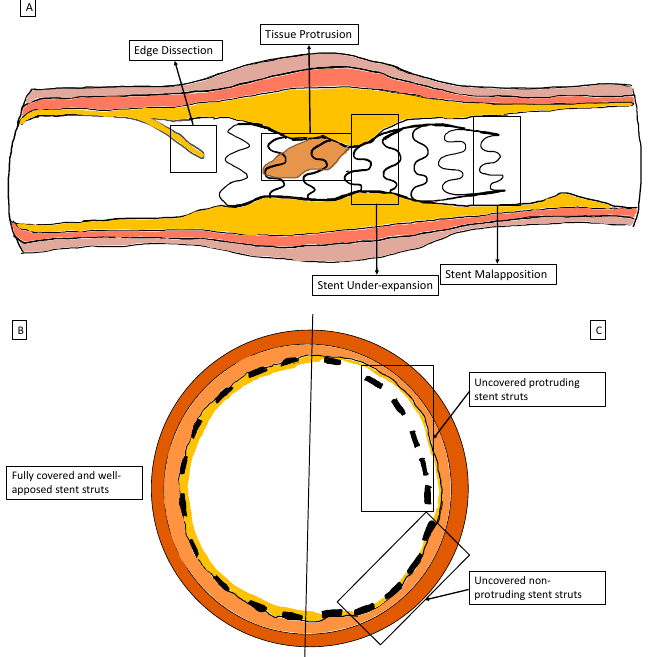
Figure 3. Schematic overview of the main OCT-based stent implantation complications: edge dissection, tissue protrusion, stent under-expansion stent malapposition (panel A ); fully covered and apposed struts (panel B ); uncovered protruding and uncovered non-protruding struts (panel C ).